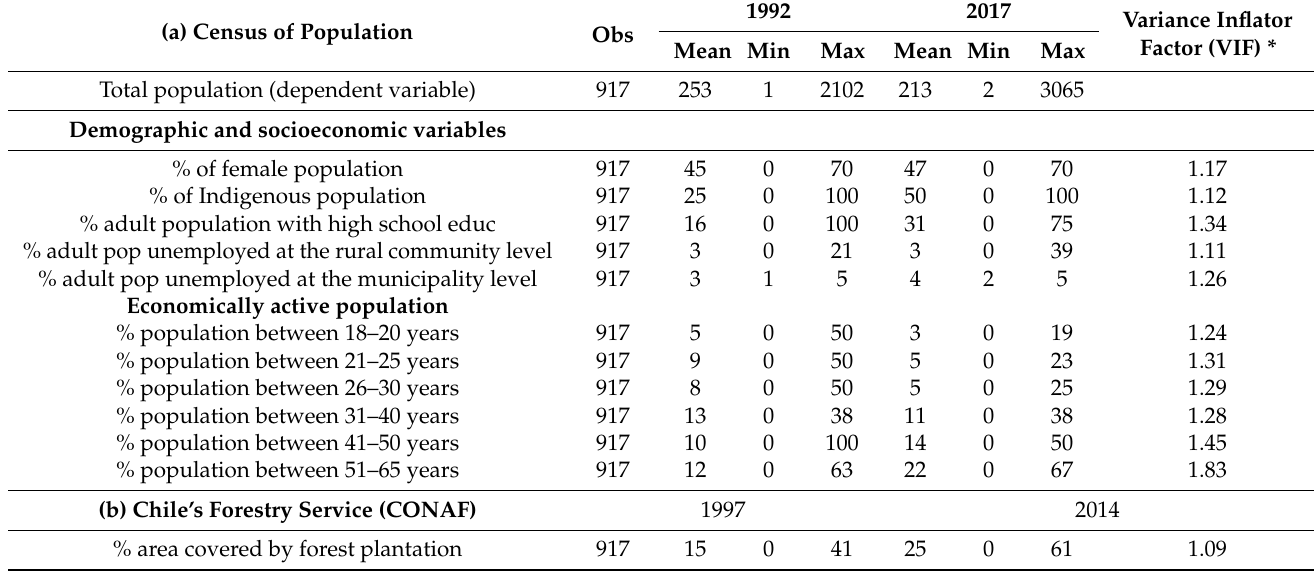
Table 1. Descriptive statistics for analysis